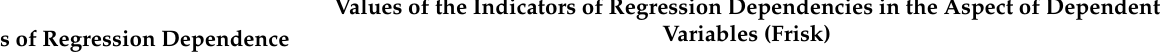
Table 7. Dependence of the financial consequences (Frisk) on investments in innovation (InvestInnov).